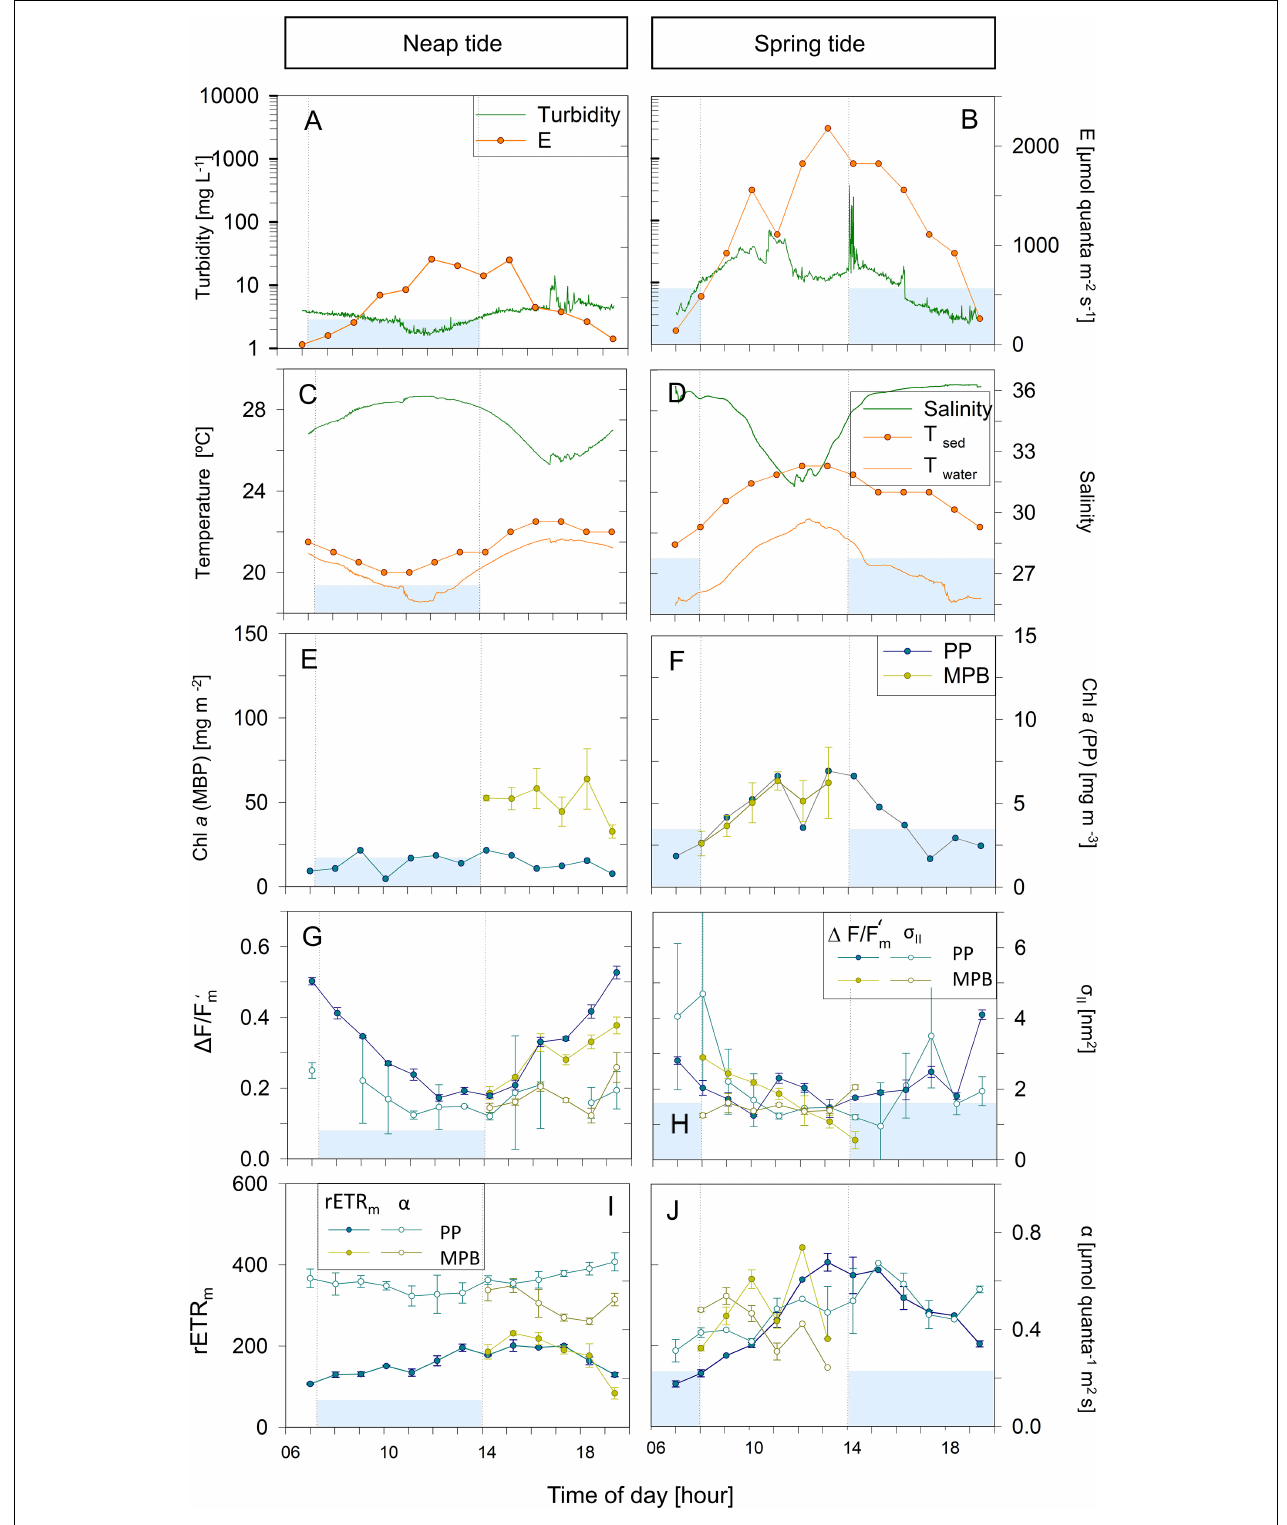
FIGURE 4 | Hourly variation of abiotic (A–D) and photophysiological (E–J) parameters along one day in Gafanha de Encarnação (GE) during neap (A,C,E,G,I) and spring tide (B,D,F,H,J) in July 2013. Blue areas represent high tide; vertical bars demonstrate the beginning and end of the high tide. Mean values of three replicates. Error bars represent one standard error. PP, phytoplankton; MPB, microphytobenthos.